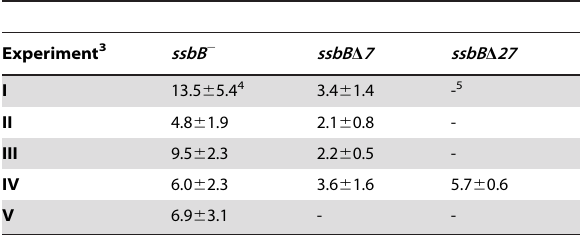
Table 1. Fold reduction in chromosomal transformation frequency 1 in ssbB 2 , ssbB D 7 , and ssbB D 27 cells 2